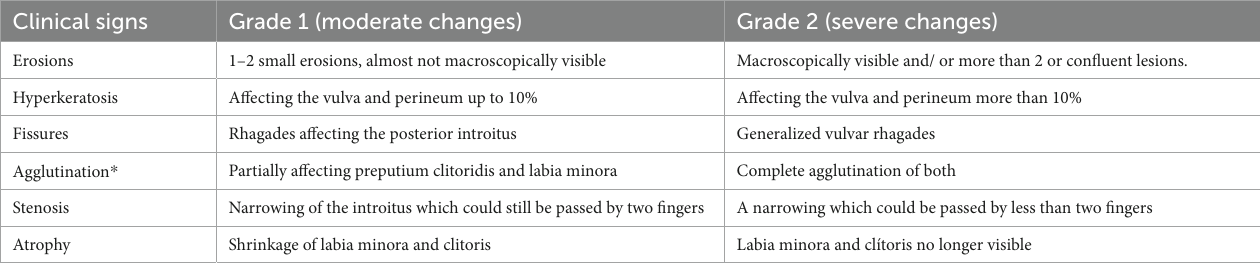
TABLE 1 Clinical score system in vulvar lichen sclerosus (122, 123). Clinical